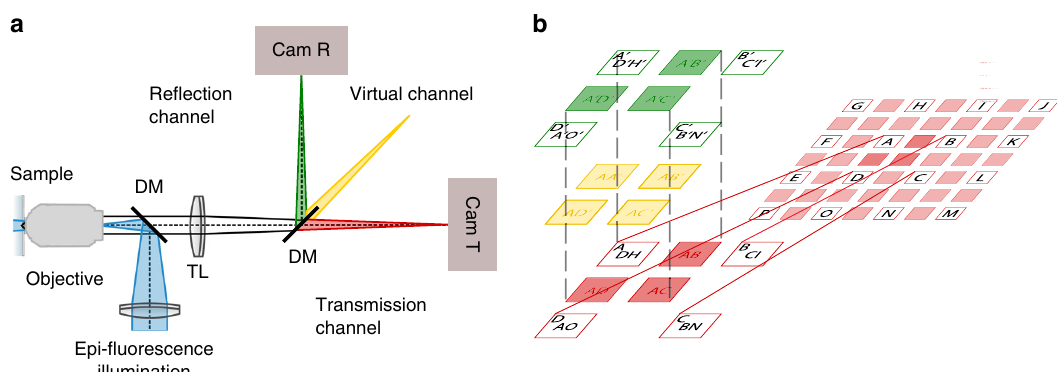
Fig. 1 Cross-cumulant analysis between spectral channels. a Simpli fi ed detection scheme with two physical spectral channels directed on two separate cameras (Cam R and Cam T, green and red). Spectral cross-cumulant analysis allows the generation of additional virtual spectral channels (yellow). DM dichroic mirror, TL tube lens, R re fl ection, T transmission. b Pixel combinations for the second-order cross-cumulant calculation. The cumulant analysis of each spectral channel (spectral auto-cumulant) is performed as described previously 16 . By cross-correlating intensities from different spectral channels (red and green) analogous to the computation of ‘ virtual ’ planes in multi-plane 3D SOFI 17 , the additional ‘ virtual ’ cross-cumulant channel is computed (yellow). Single letters denote the original pixel matrix whereas multiplets of letters symbolize cross-cumulant calculation from combinations of